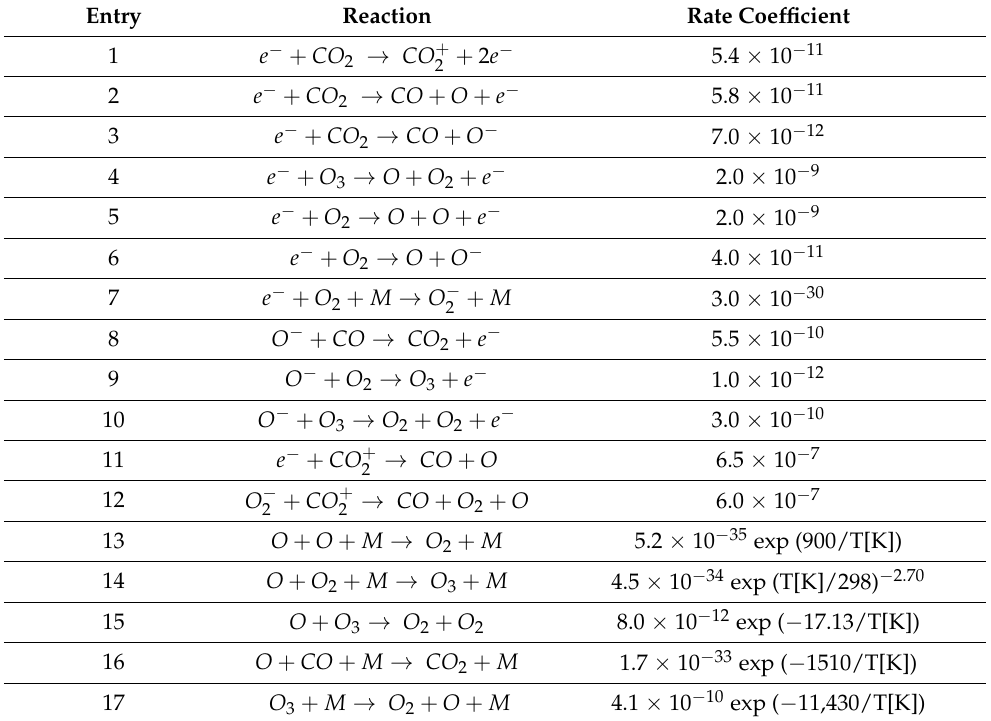
Table 1. Chemical reactions considered in the simplified kinetic model of [101] and corresponding rate coefficients (which are described as cm 3 s − 1 for the two-body reactions and as cm 6 s − 1 for the three-body reactions).